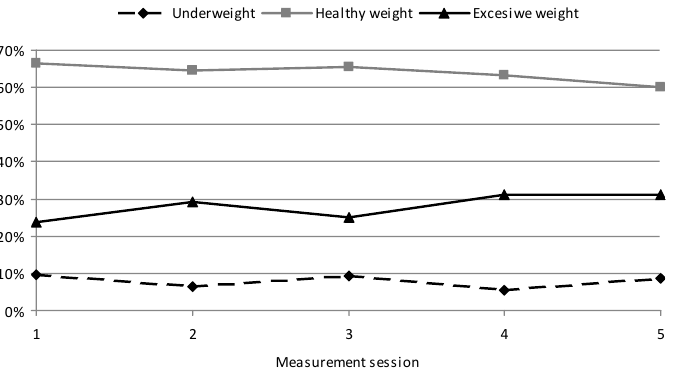
Figure 1. Changes in the percentage of excessive body weight, healthy weight, and underweight in children of standard PA (GC) during the course of the study. Oppositely to the GC, in the SC children a decrease in the percentage of children with excessive body weight was shown during the study, from 24.59% in the initial measurement session to 22.94% in the final one ( p = 0.000). The percentage of underweight children decreased from 10.66% to 6.55% ( p = 0.012) (Figure 2). A growing percentage of the SC children with healthy weight from 64.75% to 70.51% was shown (an increase by 5.76%) ( p = 0.000). The highest percentage of underweight SC children was shown at the start of the study (10.66%), while the lowest one in the final measurement session (6.55%). The percentage of children with excessive body weight was the lowest in the 4th measurement session (25.42%) and the lowest in the 3rd measurement session (22.14%); however, these differences were not significant.